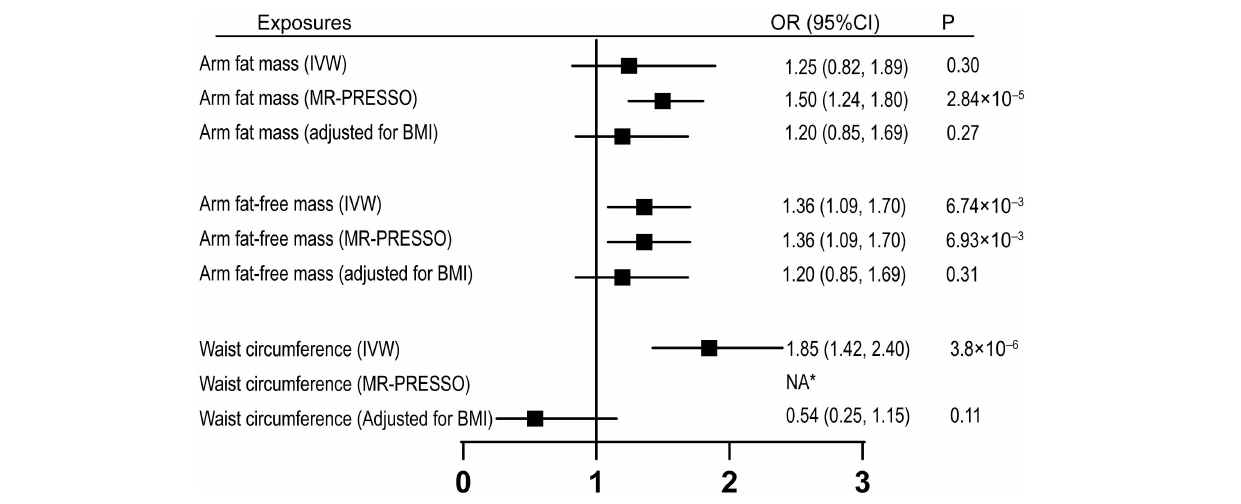
FIGURE 3 | Univariable MR and multivariable MR analyses showing the associations of genetically proxied obesity-related factors with carpal tunnel syndrome. 1 SD increase of arm fat mass, arm fat-free mass, and waist circumference showed increased risk of carpal tunnel syndrome with outliers adjusted by MR-PRESSO. However, the causal associations were absent after adjustment for BMI. *No outlier detected. IVW, inverse-variance-weighted; BMI, body mass index; SD, standard deviation; OR, odds ratio; CI, confidence interval; MR, Mendelian